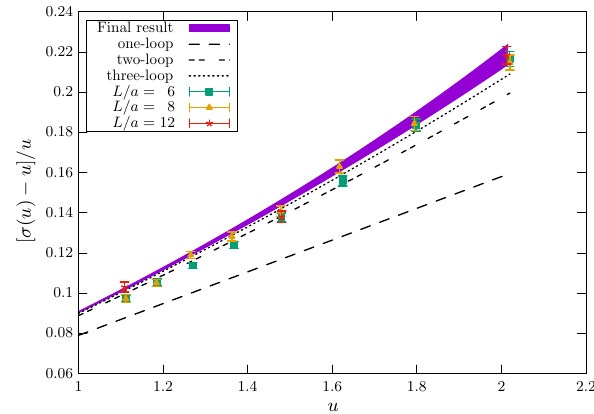
Fig. 2 The step-scaling function for the ν = 0 SF-coupling. The band shows our result (fit C, cf. Table 5). The data points are the approxi- mations at finite L / a = 6 , 8 , 12 taken from Table 4 with errors from Eq.